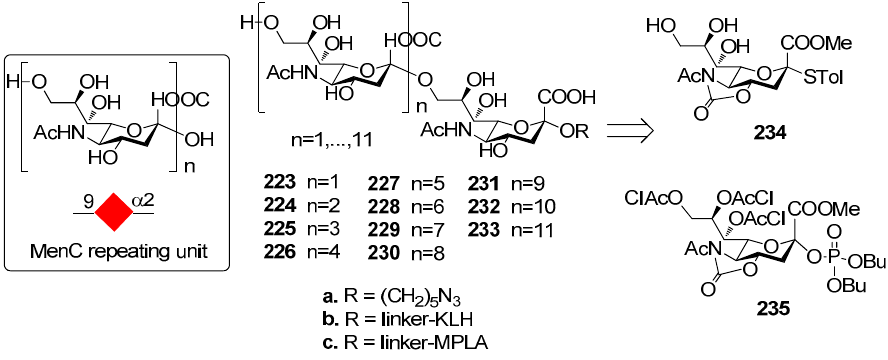
Figure 25. Repeating unit of MenC CPS and synthetic fragments reported in [191,192].